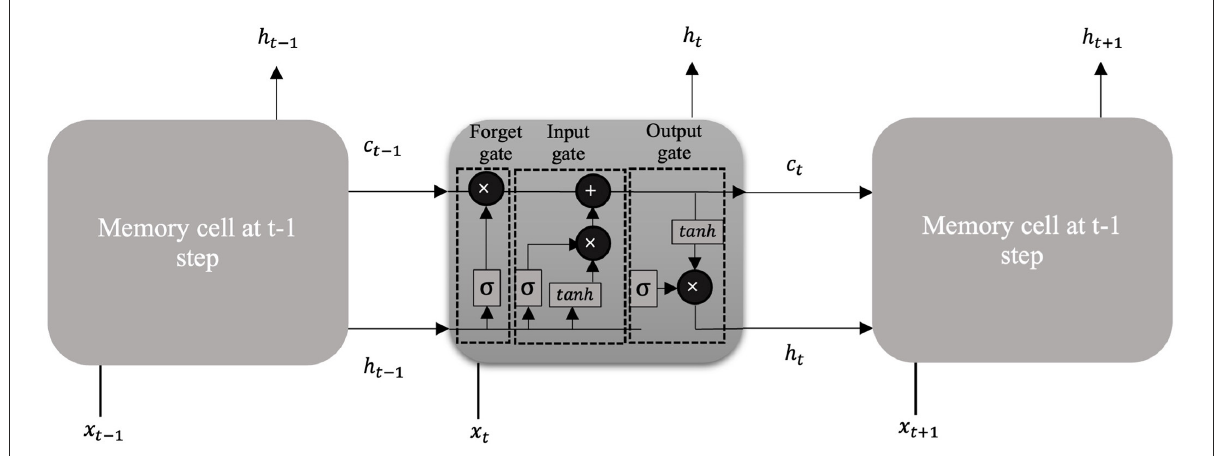
FIGURE4 An illustration of the LSTM